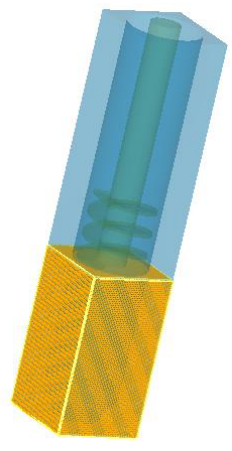
Figure 17. Mesh generation of simplified FCM